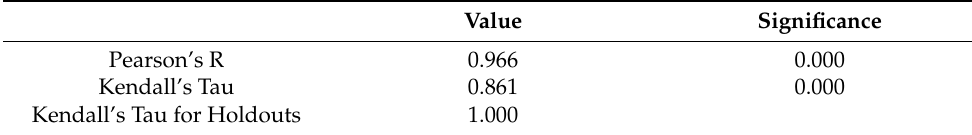
Value Significance